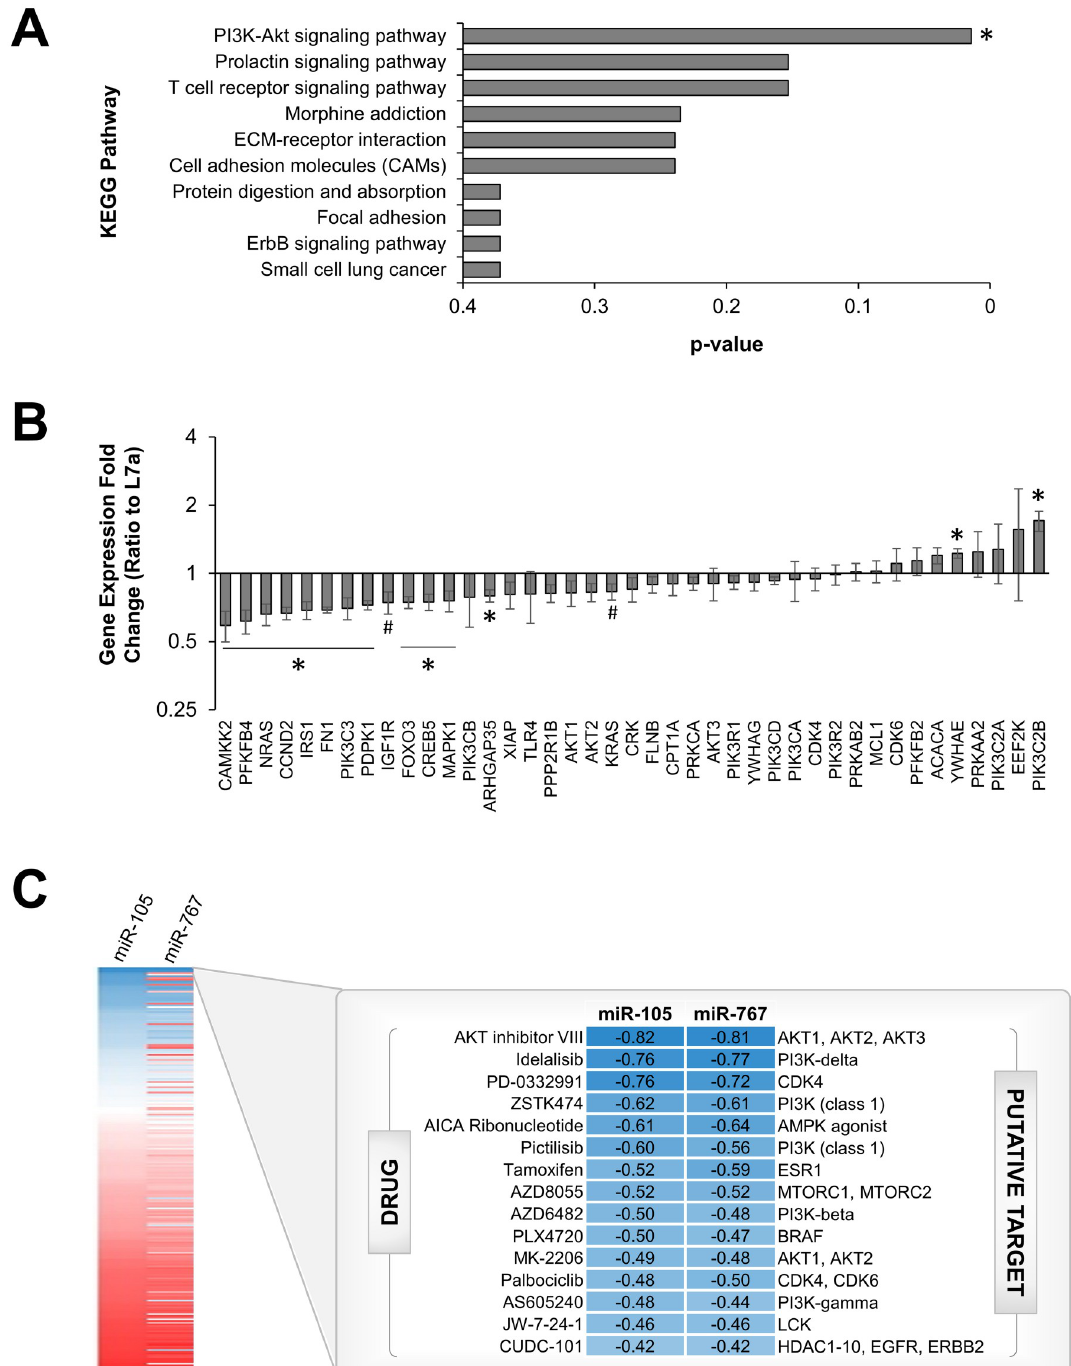
Fig 6. miR-105 and miR-767 target genes in the PI3K-AKT pathway. (A) KEGG pathway analysis was performed on the top 1,000 predicted gene targets of miR-105 and miR-767. False discovery rate corrected p-values are reported. (B) miR-105 and miR-767 were overexpressed in HepG2 cells. qPCR was used to measure expression of genes that were putative targets of both miR-105 and miR-767 and/or played a crucial role in the PI3K-AKT signaling pathway. � p < 0.05. (C) The heat map shows correlations between miR-105/ 767 expression and drug IC50 values. Blue represents negative values while red denotes positive values. The top 15 drugs with the most negative correlation between miRNA and IC50 represent drugs that are most effective at killing high miR-105 and miR-767-expressing cell lines. Drug names are reported on the left and their putative protein targets are given on the right.